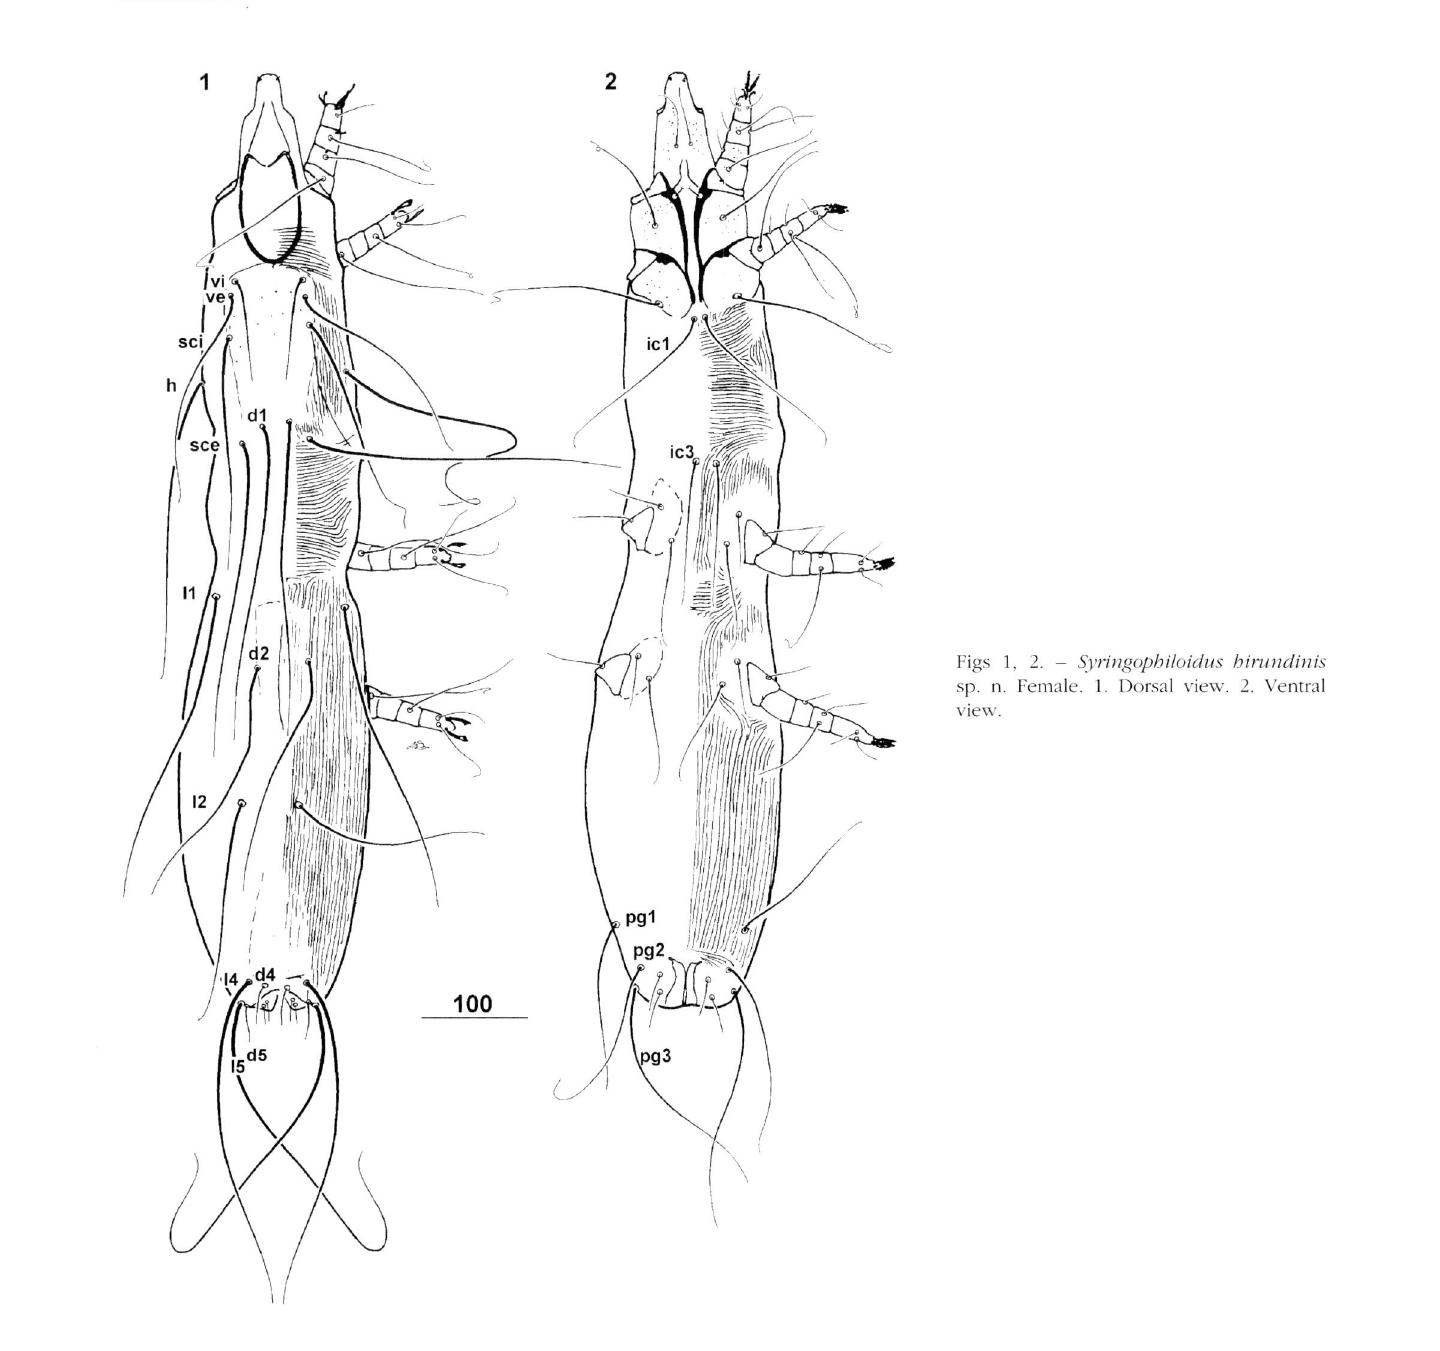
Figs 1, 2. - Syringophiloidus hirundinis sp. n. Female. 1. Dorsal view. 2. Ventral